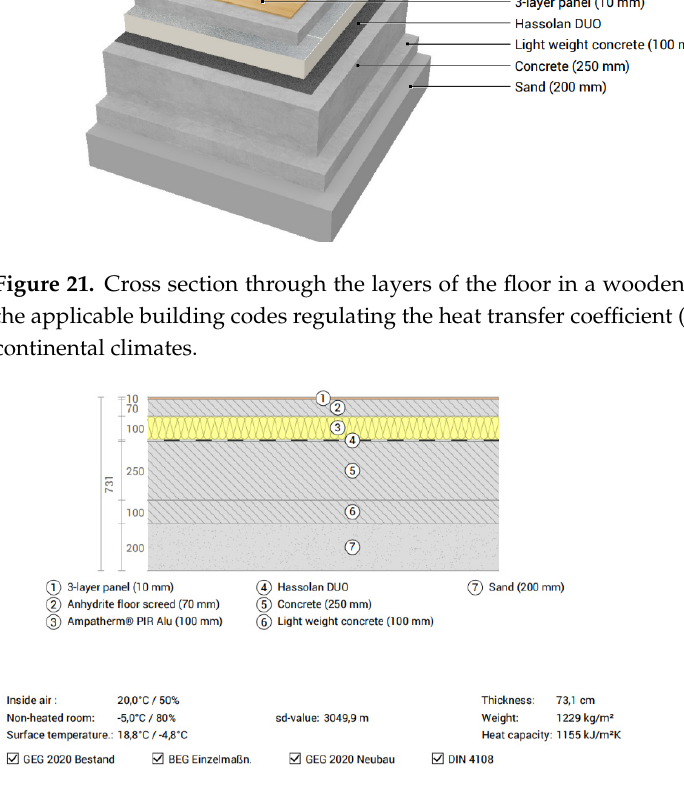
Figure 22. Cross section through the floor layers in a frame building.